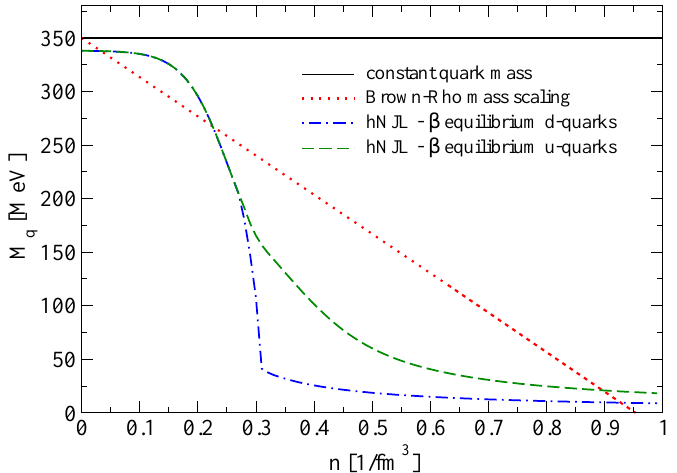
Figure 2. Dependence of the quark masses on density: constant quark mass (solid line), Brown–Rho scaling (dotted line), Nambu–Jona-Lasinio (hNJL) model in β -equilibrium for u-quarks (dashed line) and for d-quarks (dash-dotted